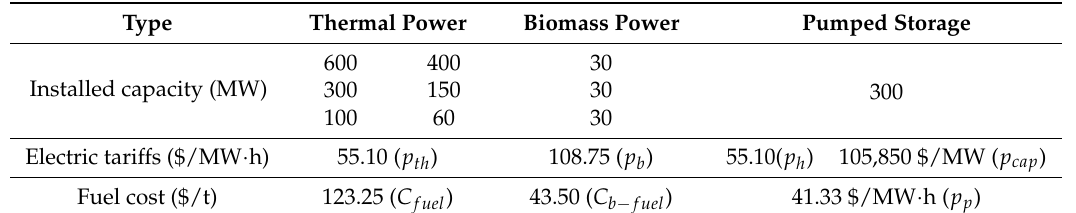
Table 1. The generator set of dispatching system (MW).